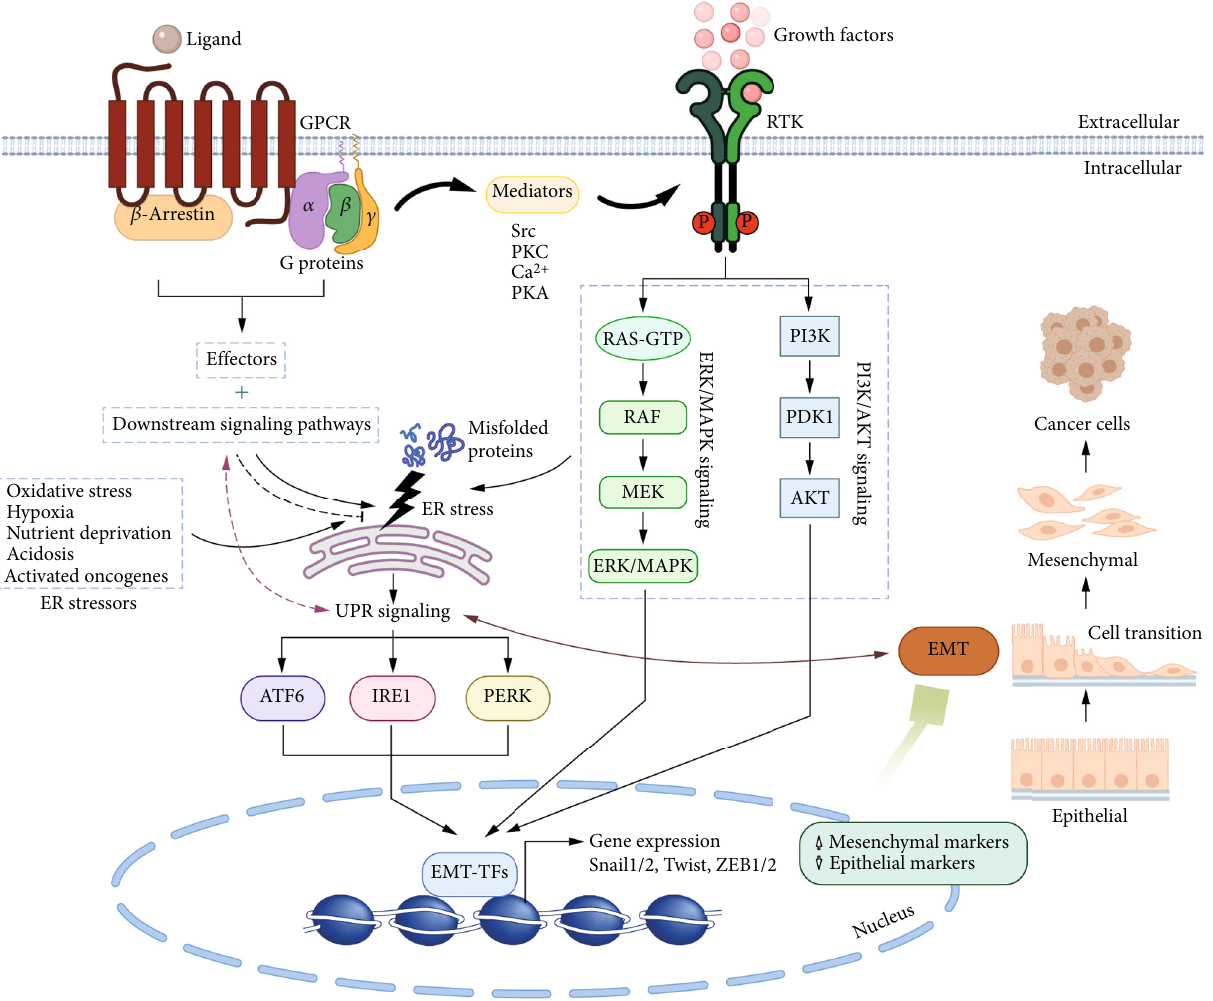
Figure 2: Crosstalk of GPCR signaling and ERS during EMT. Activation of GPCRs and ERS facilitates the EMT process of cancer cells. Upon ligand binding, GPCRs transmit signals via heterotrimeric G proteins, β -arrestins, and crosstalk with receptor tyrosine kinases (RTKs) through signaling mediators. The activation of RTKs by growth factors drives EMT through ERK/MAPK and PI3K/AKT signaling cascades which in turn lead to induction of ERS. GPCRs controlling downstream e ff ectors and multiple signaling pathways regulate ERS by interacting with IRE1, PERK, and ATF6 arms of the UPR. The UPR signaling is stimulated by ER stressors including oxidative stress, hypoxia, nutrient deprivation, acidosis, and activated oncogenes. Bidirectional crosstalk between UPR and cell signaling pathways re fi nes cellular stress responses (dotted double arrow). GPCRs can either activate (curved arrow) or inhibit (curved dotted line) ERS. GPCR-ERS- induced UPR signaling pathways concurrently induce EMT during tumorigenesis. Activation of EMT occurs in response to GPCR- mediated signaling and ERS by upregulation of EMT-TFs (Snail1/2, Twist, and ZEB1/2), accompanied by an increase of mesenchymal markers and a decrease of epithelial markers. Reciprocal regulation between EMT and UPR signaling is observed during tumor progression (curved double